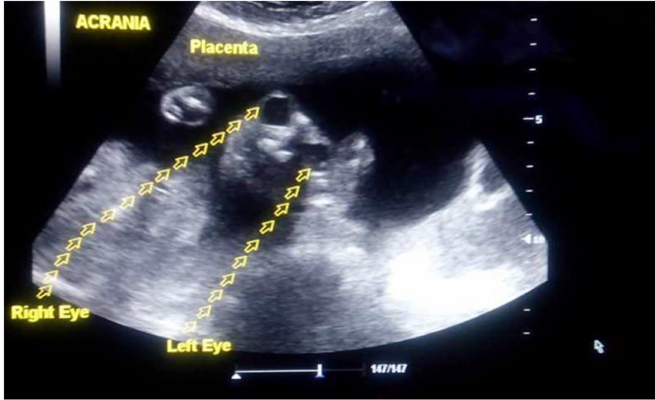
Figure 3. Ultrasound image of anencephaly.